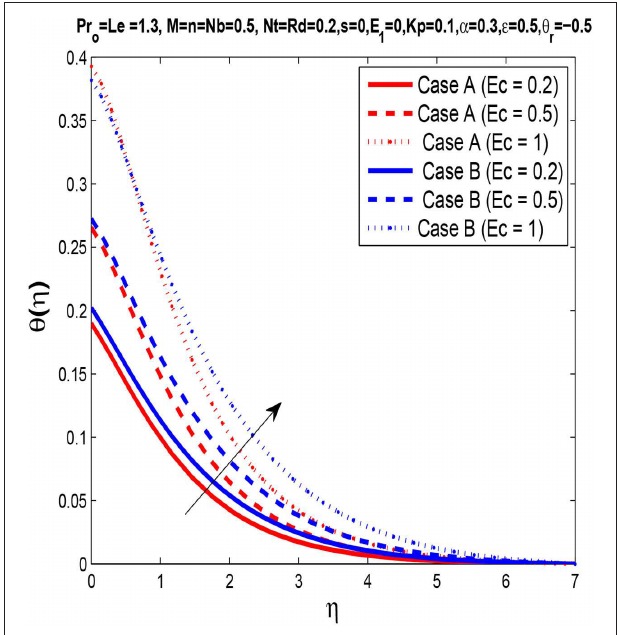
FIGURE 7 | Temperature profile θ ( η ) for different values of Pr o .